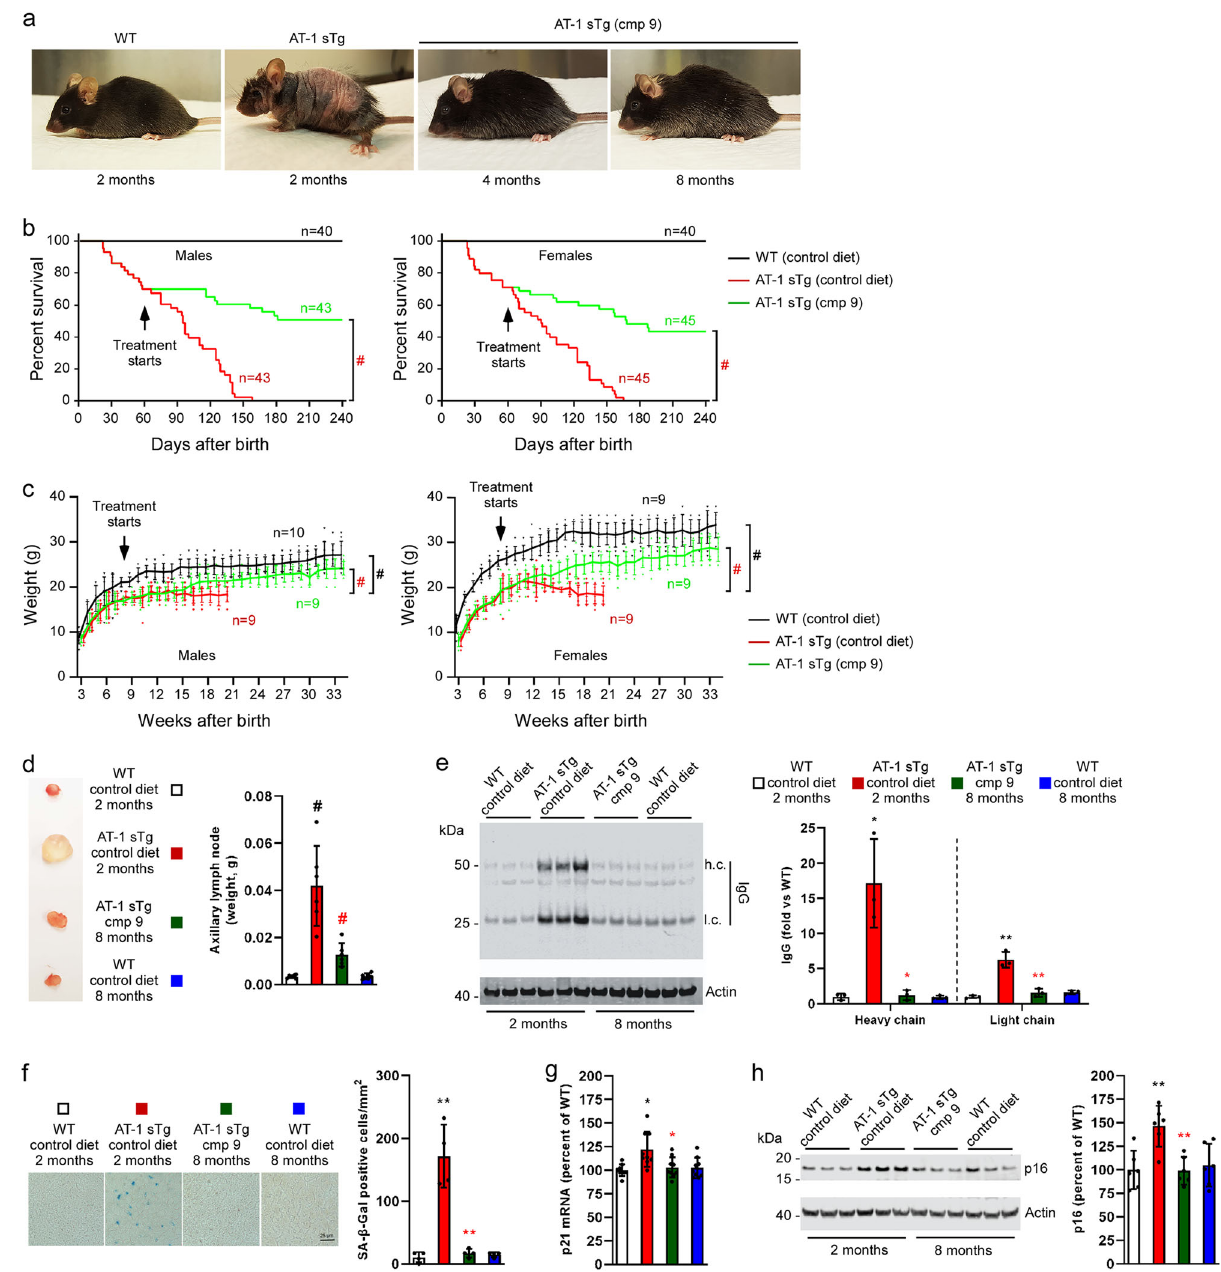
Fig. 1 Late treatment with Compound 9 rescues the AT-1 sTg phenotype. a Representative images of WT mice at 2 months of age and AT-1 sTg mice at 2, 4, and 8 months of age. Compound 9 treatment started at 2 months of age. b Lifespan of AT-1 sTg mice on control diet versus Compound 9 diet. c Body weight of AT-1 sTg mice on control diet versus Compound 9 diet. d Representative image (left panel) and weight quanti fi cation (right panel) of axillary lymph nodes. e Representative Western blot (left panel) and quanti fi cation (right panel) of IgG heavy chain (h.c.) and light chain (l.c.) levels in liver. f Representative images (left panel) and quanti fi cation (right panel) of SA- β -Gal staining in liver. g p21 mRNA quantitation in liver. h Representative Western blot (left panel) and quanti fi cation (right panel) of p16 levels in liver. Bars represent mean ± SD. * p < 0.05, ** p < 0.005, # p < 0.0005 via ordinary two-way ANOVA with Tukey ’ s multiple comparison test. Black symbol, signi fi cance vs WT; Red symbol, signi fi cance vs untreated AT-1